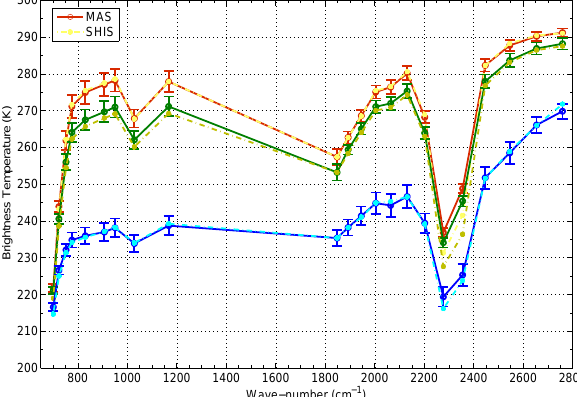
Fig. 11. MAS data averaged over S-HIS nadir FOV and S-HIS data convolved with MAS relative spectral response. The red solid line and yellow dashed refer to Sector 1 (the thin cloud layer); the two green shades are for Sector 2 (medium cloud layer) and the blue lines are for the moderately thick layer of Sector 3. The vertical bars are the one standard deviation of the MAS data around the average values and denote the natural variability as well as radiometric